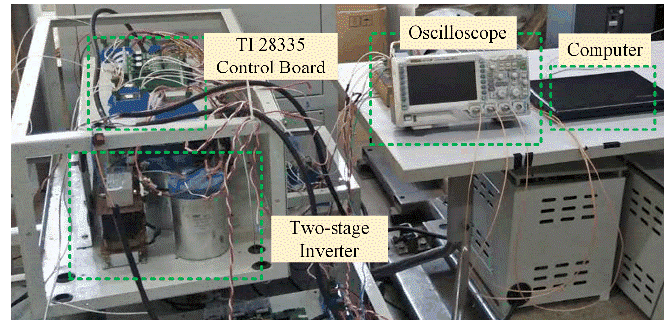
Figure 14. Experimental platform.